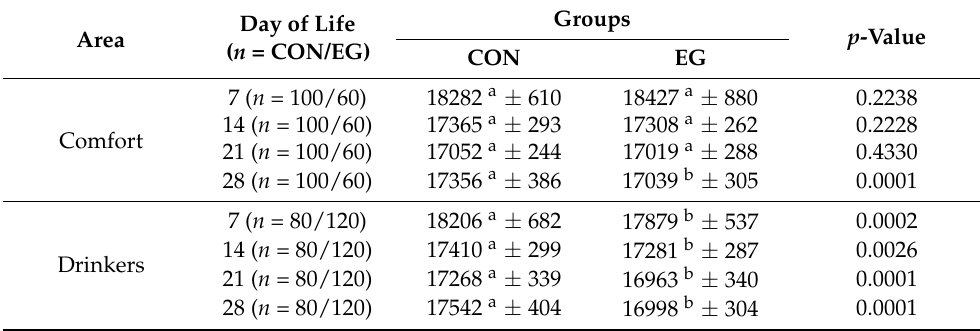
Table 7. Calorific values (J/g DM) of the litter in comfort and drinker areas from d 7 to d 28 (mean ± SD).